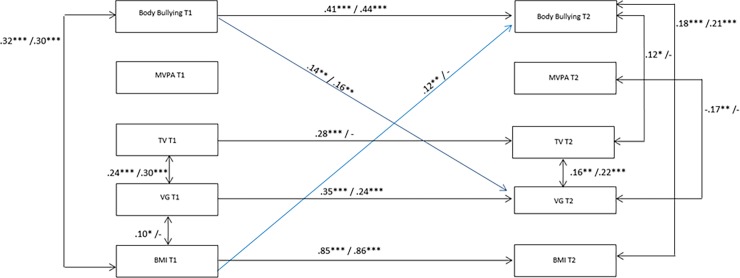
Baseline, forward causation, reversed causation and reciprocal models for HRSB and body bullying.A. Model 1: Auto-regressive effects and cross-sectional correlations; B. Model 2: Body bullying at T1 predicts HRSB at T2; C. Model 3: HRSB at T1 predict body bullying at T2; D. Model 4: Body bullying and HRSB have reciprocal effect. All models were adjusted by socioeconomic information and psychological well-being- omitted in the Fig 1.